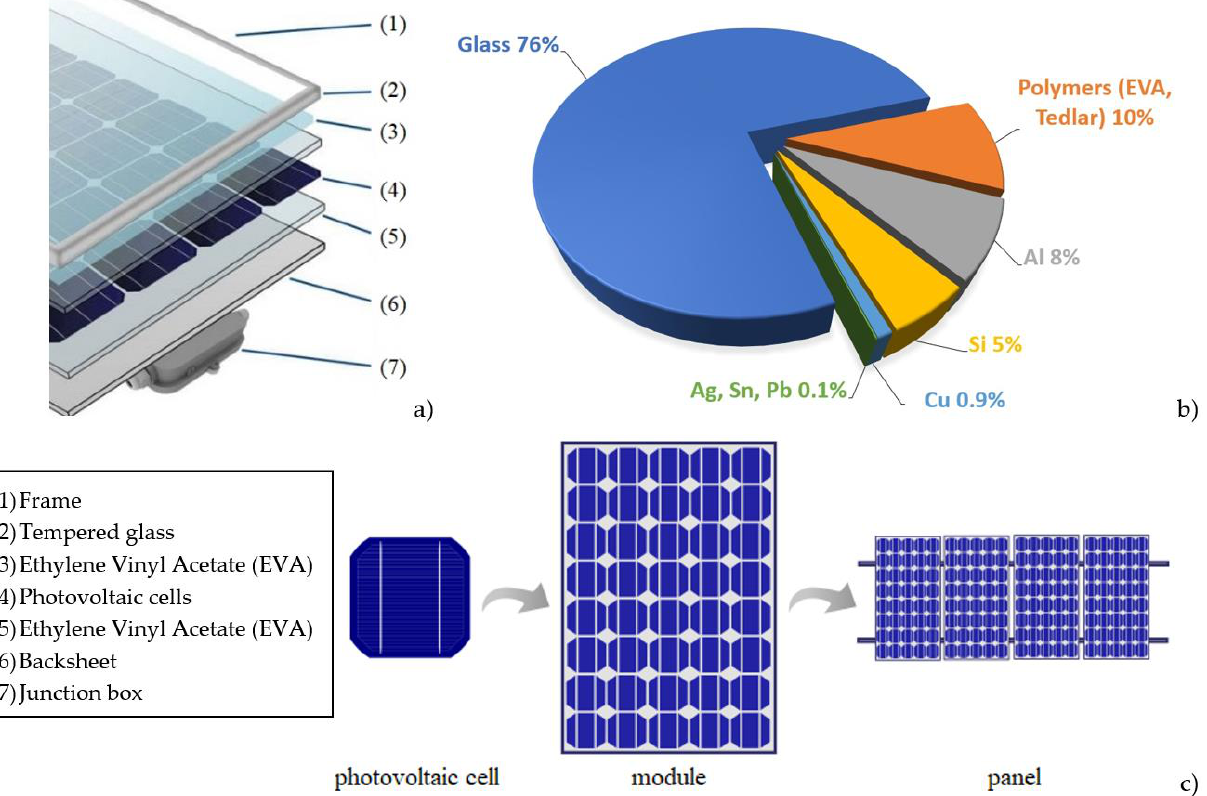
Figure 8. ( a ) Standard PV panel structure (source [20]); ( b ) Standard PV panel composition; ( c ) PV panel structure.